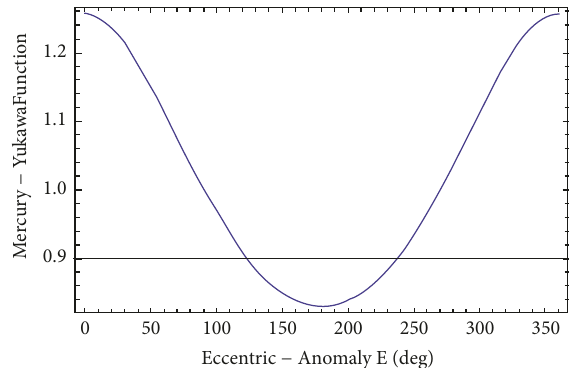
Figure 2: Plot of the Yukawa function for planet Mercury as a function of eccentric anomaly during a full revolution.